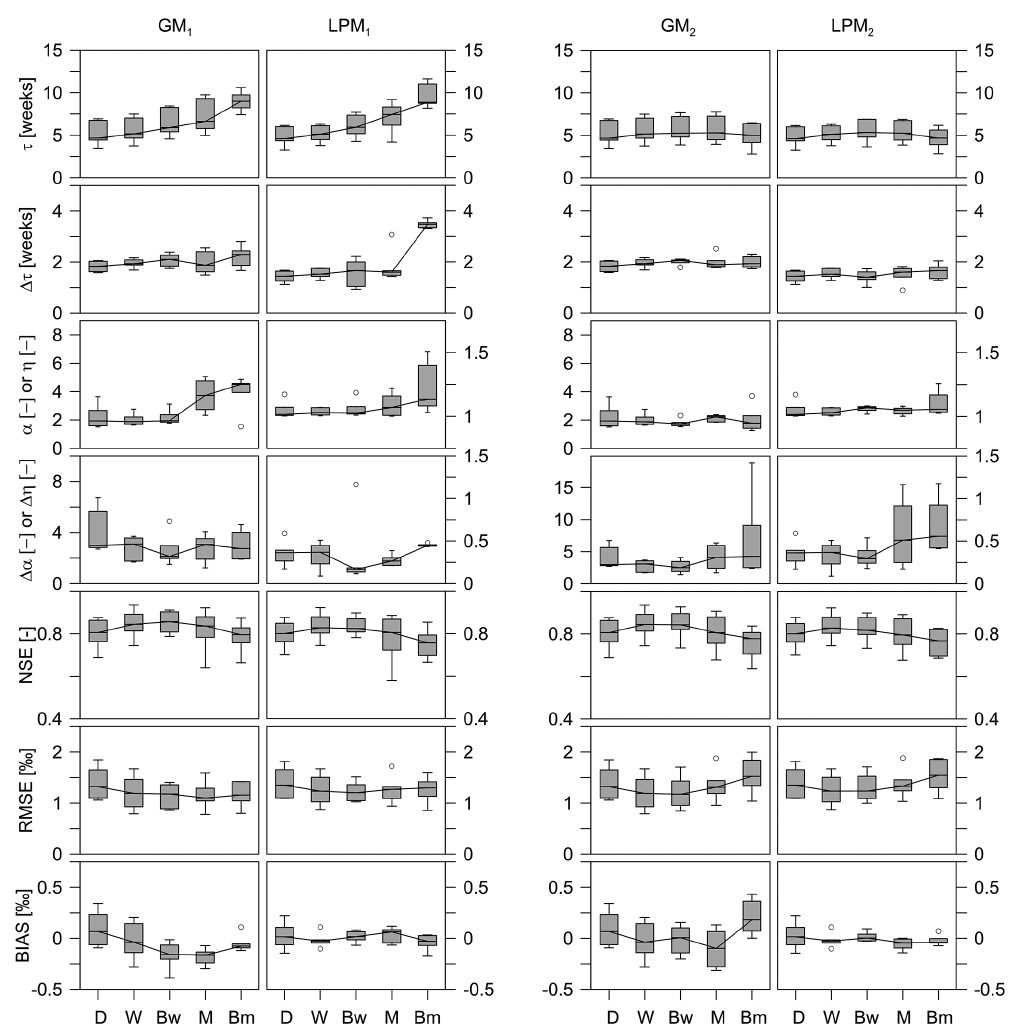
Figure 2. Comparison of predictions for soil water sites using gamma (GM) and linear-piston (LPM) lumped models. Subscript in the model name stands for the type of scenario: Sc1 is aggregation of sampling frequency in the rainfall and also in the effluent, Sc2 is aggregation of sampling frequency only in rainfall data. Acronyms in the x axis of all plots stands for five types of data resolution: D is daily, W is weekly, Bw is bi-weekly, M is monthly and Bm is bi-monthly. Box plots markers correspond to quartiles and median values (–). The length of whiskers is limited to 1.5 times the width of the box and values located further away below the first quartile or above the third quartile are considered extreme ones ( ◦